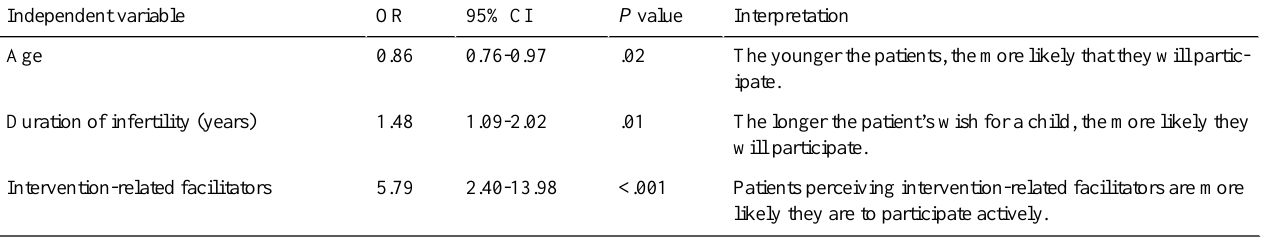
Table 6. Multivariate relationship of background characteristics and sum scores of barriers and facilitators to participate actively within the online health community after